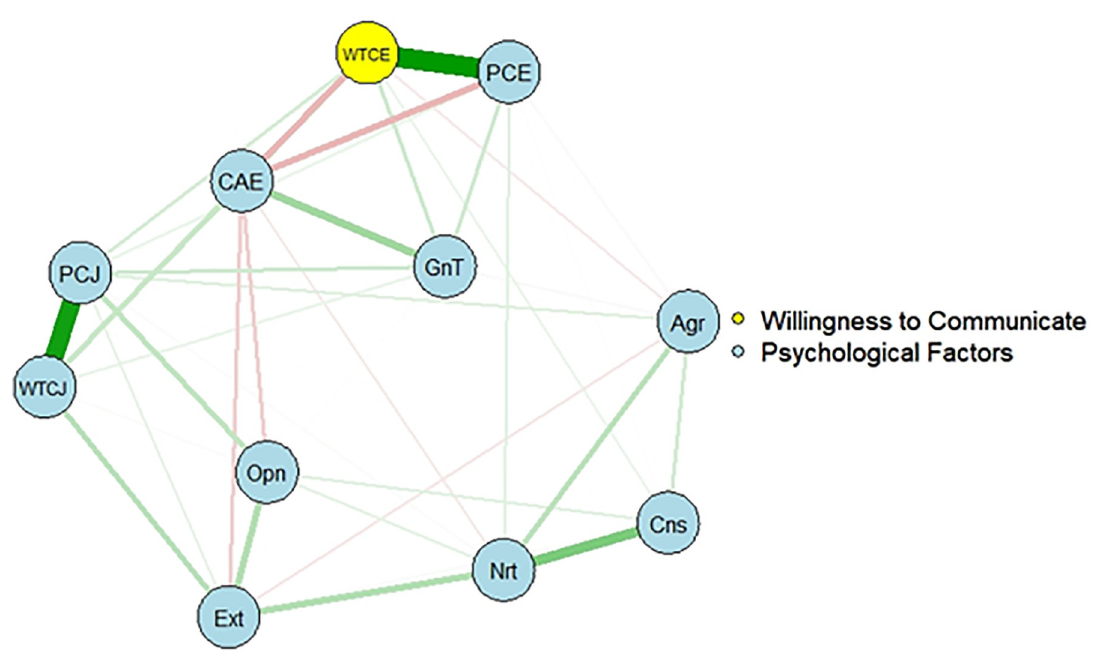
Fig 1. The network structure of psychological factors and the WTC in English. Nodes represent observed variables, and links represent partial correlations between two factors, after controlling for all other factors. Green link means positive correlations and red link means negative correlations. WTCE = Willingness to Communicate in English; PCE = Perceived communication competence in English; CAE = Communication anxiety in English; WTCJ = Willingness to Communicate in Japanese; PCJ = Perceived communication competence in Japanese; GnT = General Trust; Ext = Extraversion; Cns = Conscientiousness; Nrt = Neuroticism; Opn = Openness; Agr = Agreeableness.